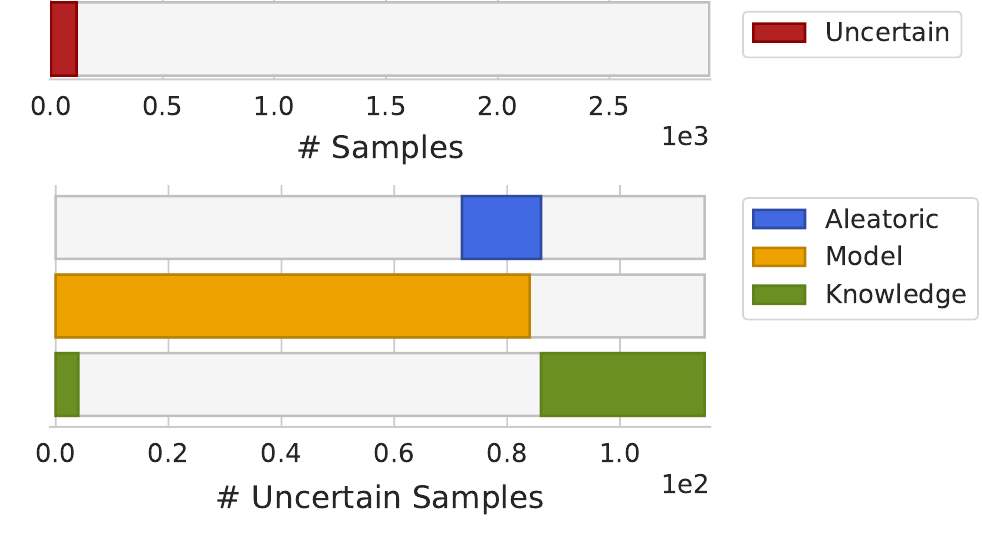
Figure 10. HAR dataset uncertainty overview.